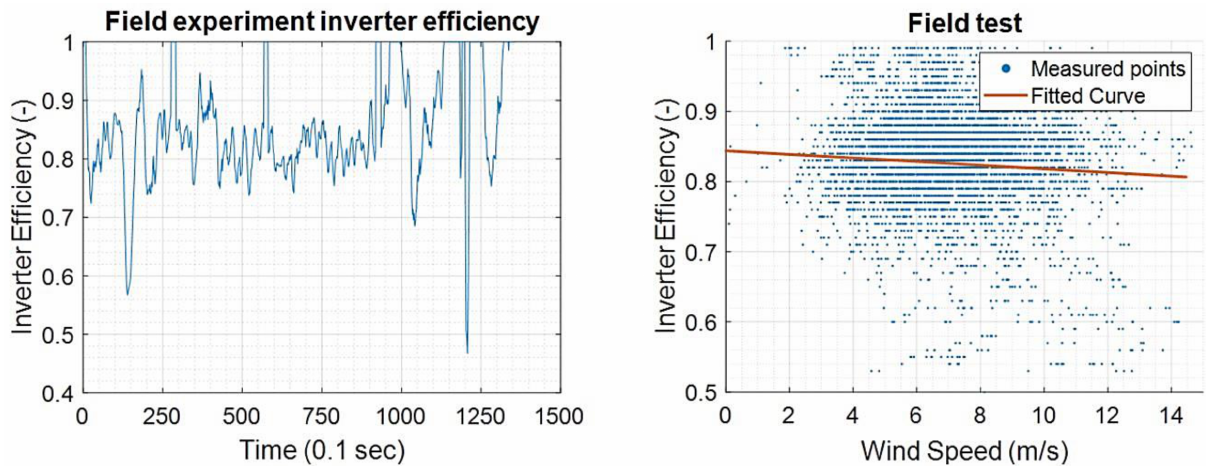
Figure 14. ( left graph) Time series plot of a 2-min dataset ( right graph) Scatter plot of field test for a 22 min dataset of measured inverter operating efficiencies for WindChallenge downwind turbine with average wind speed of 6